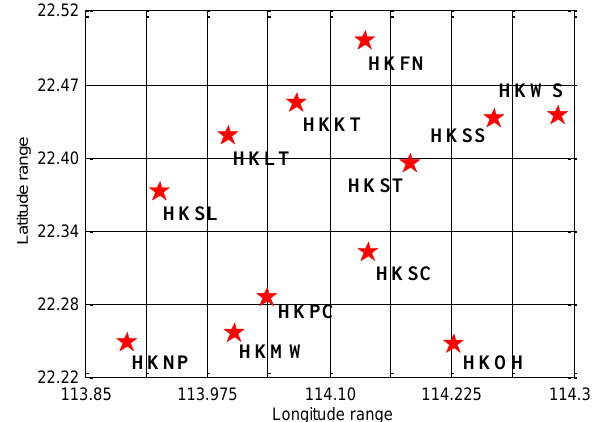
Fig. 5. Horizontal grid division in Hong Kong. The units in latitude and longitude directions are